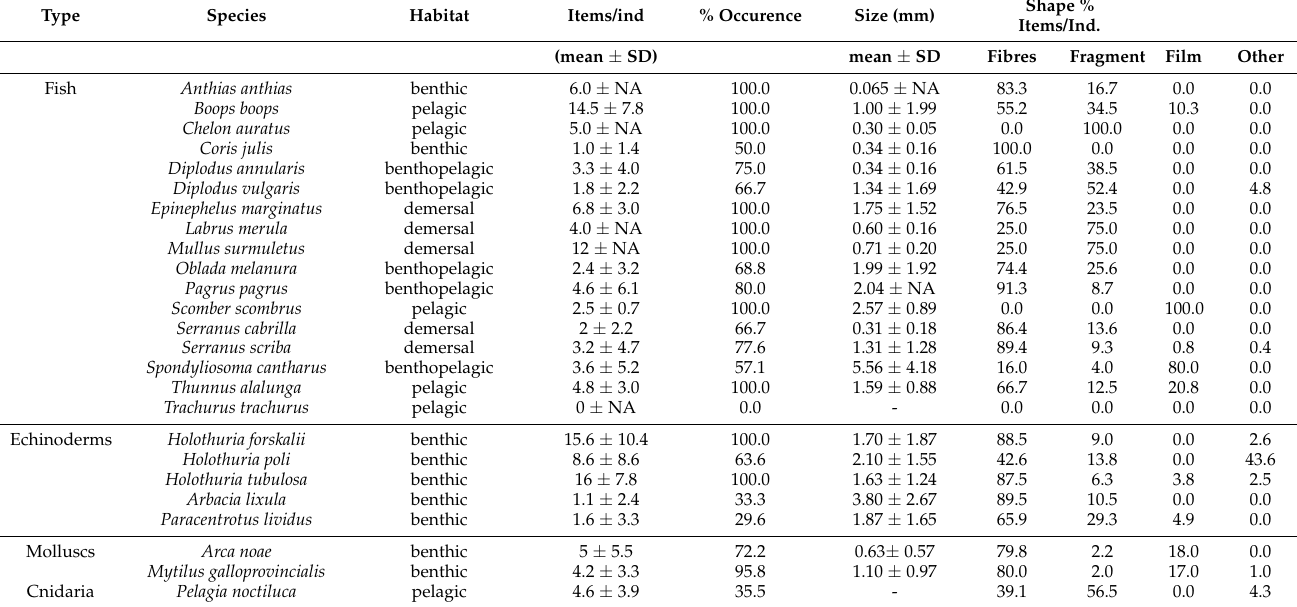
Table 2. Summary of the mean and standard deviation (mean ± SD) values of ingested anthropogenic particles per individual (items/ind.), frequency of anthropogenic particles (APs) occurrence (%), mean and standard deviation (mean ± SD) values of size of identified items (mm) and percentage of occurrence (%) of items according to item shape (fibres, fragment, film and other) identified in the studied species.